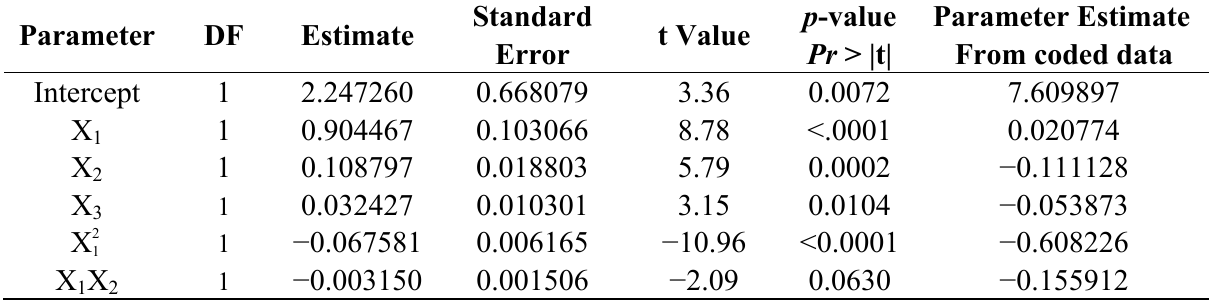
Table 2. Variance analysis of extraction